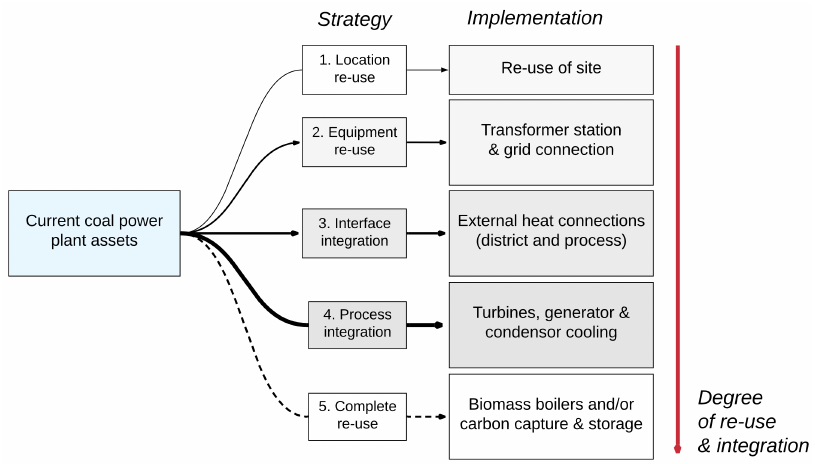
Figure 7. General scope of re-utilization options for existing coal